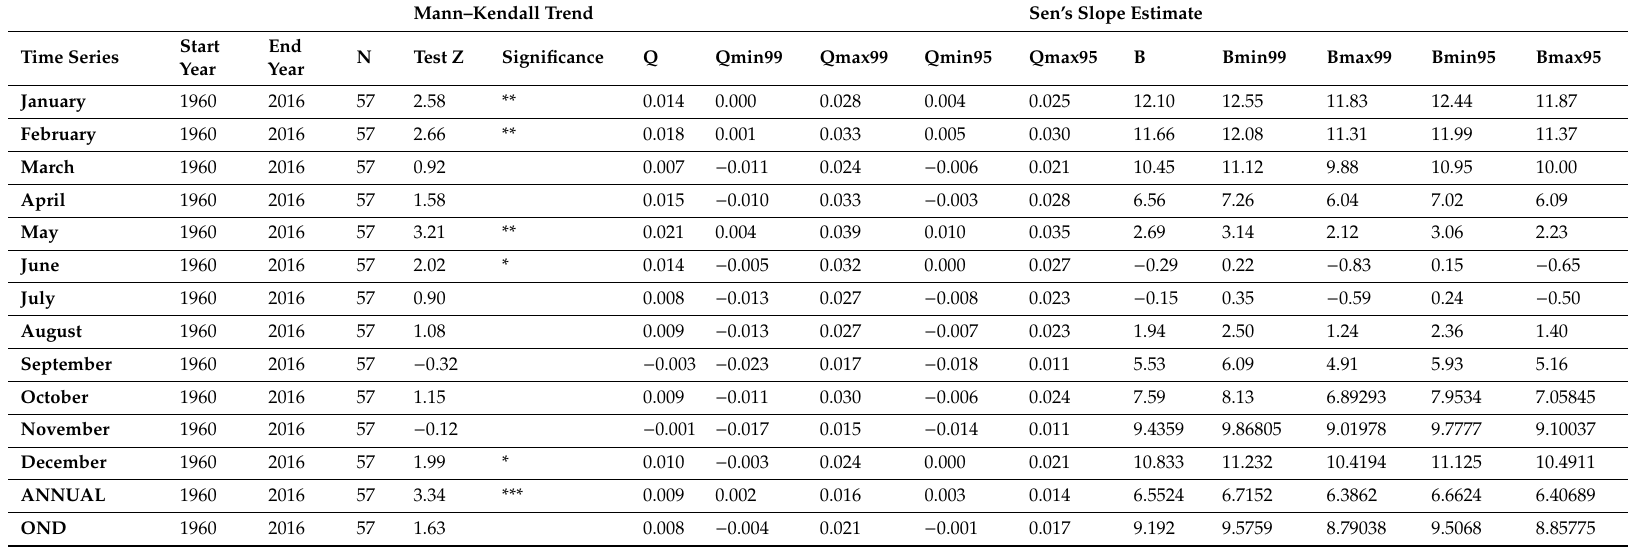
Table 4. Annual average minimum temperature trend